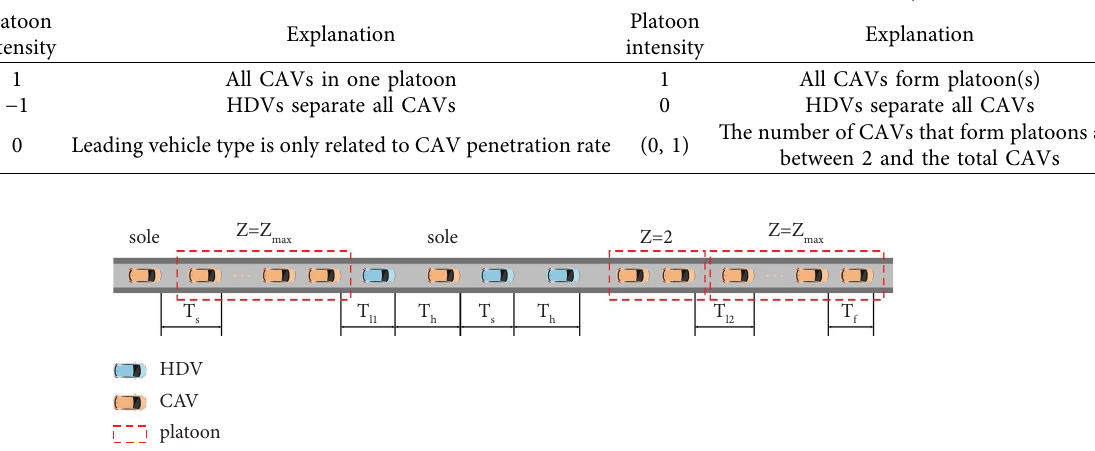
Figure 2: Car-following modes in mixed trafc